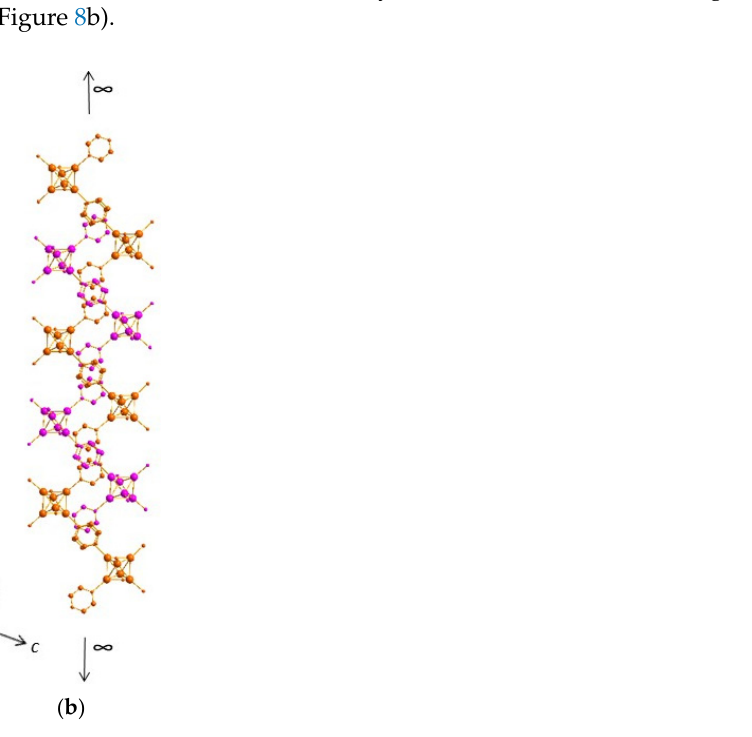
Figure 7. ( a ) Infinite chain of cluster units linked by π – π stacking involving adjacent coordinated pyrazine molecules along the a axis in the structure of ( 4 ). Clusters on the top and clusters on the bottom of the figures are depicted in two different colors (orange and pink). ( b ) View of two pillared adjacent infinite chains in the structure of ( 4 ).